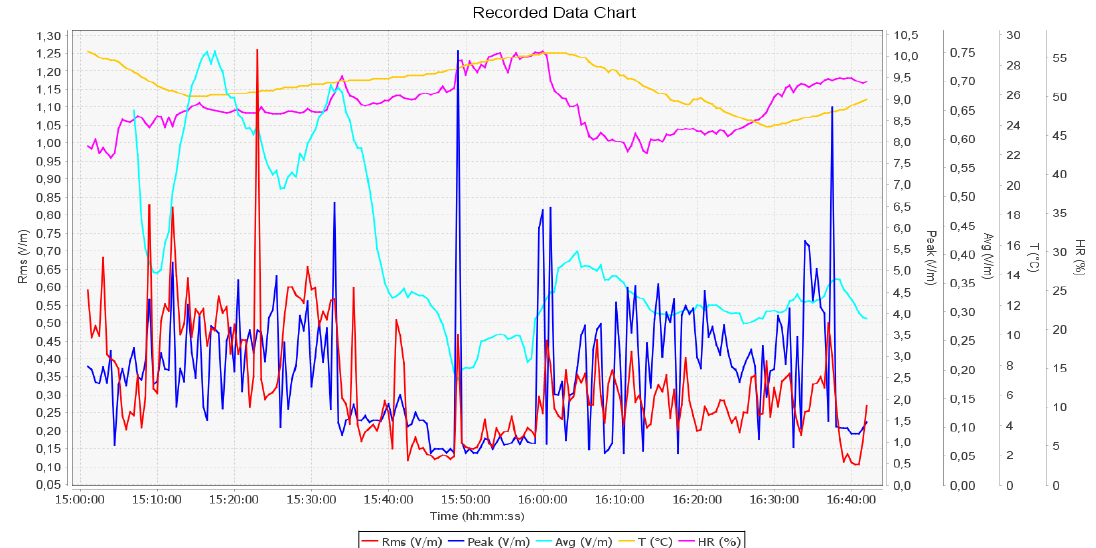
Figure 10. The intensity of the electrical component of the electromagnetic field in the course of flight no. 2 for the Tecnam P2006T.